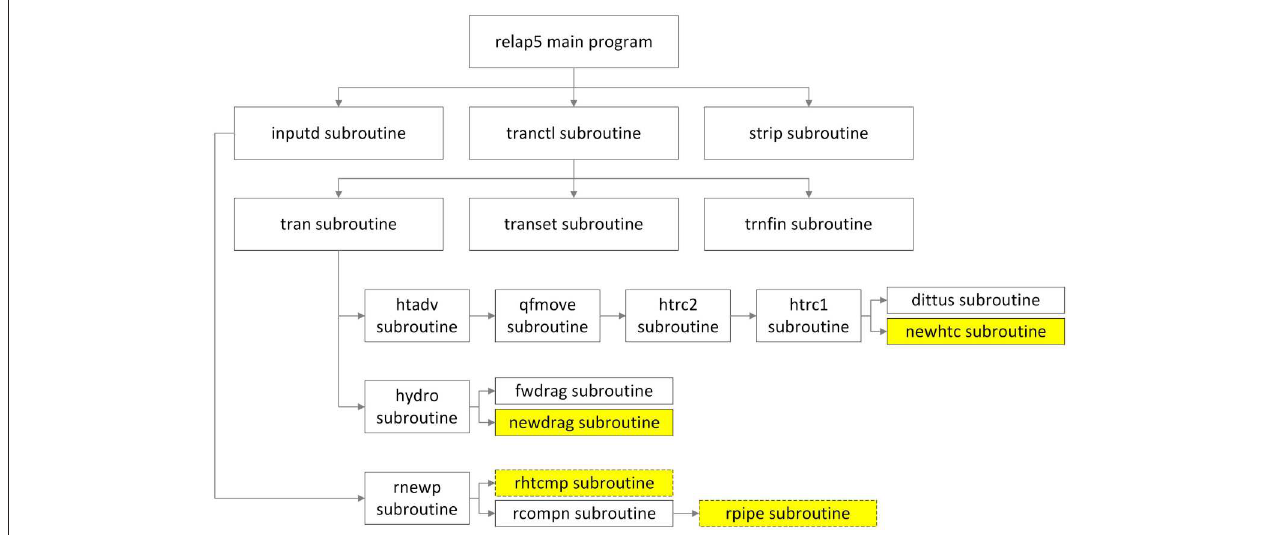
FIGURE 3 | Structure of the RELAP5/MOD3.1